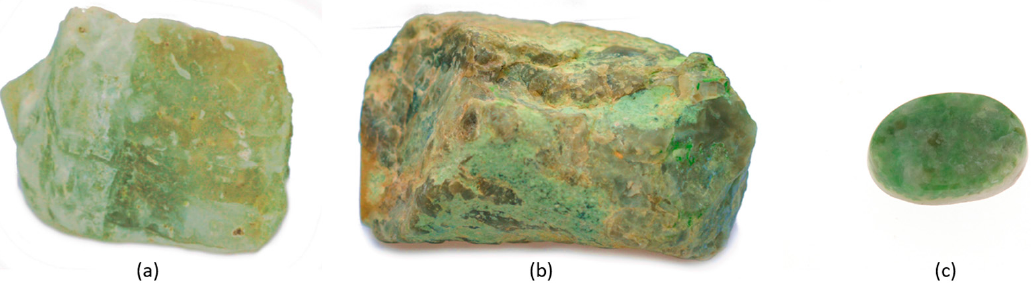
Figure 3. Mineralogical samples of ( a ) grossular/hydrogrossular and ( b ) grossular/hydrogrossular in rhodingite rock association; ( c ) rhodingite-polished tablet. Photos: M. Musa—GIG.